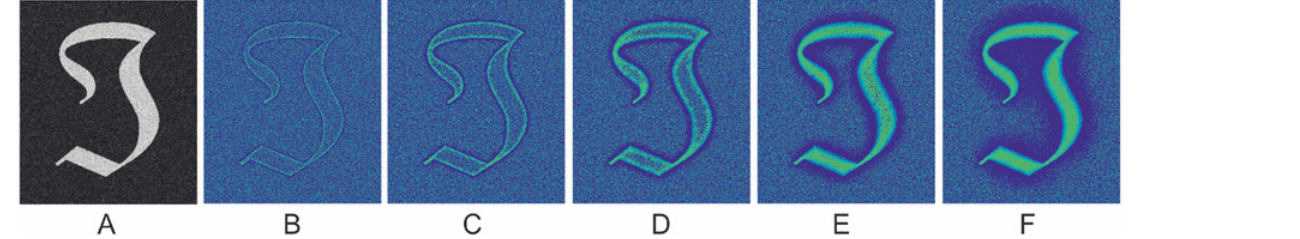
Fig 2. Illustration of the enhancement effect on a test image using the local phase filter at different scales from 1 to